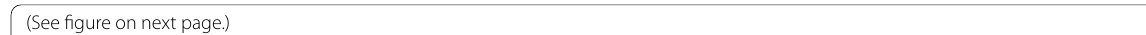
(See figure on next page.) Fig. 4 Histopathological findings. a On low‑powered magnification, lymphatic follicle formation and glass‑like fibrosis could be seen. b On high‑powered magnification, infiltration of plasma cells and lymphocytes could be observed. Malignant features were not present. c–e Immunohistochemistry for CD31 ( c ), CD68 ( d ), alpha‑smooth muscle actin (α‑SMA) ( e ), human serum albumin (HSA) ( f ), glypican 3 (GPC3) ( g ), and alpha‑fetoprotein (AFP) ( h ). Tumor cells were diffusely positive for CD31, and partially positive for CD68 and α‑SMA, whereas human serum albumin and glypican 3 were negative. There were some tumor cells positive for